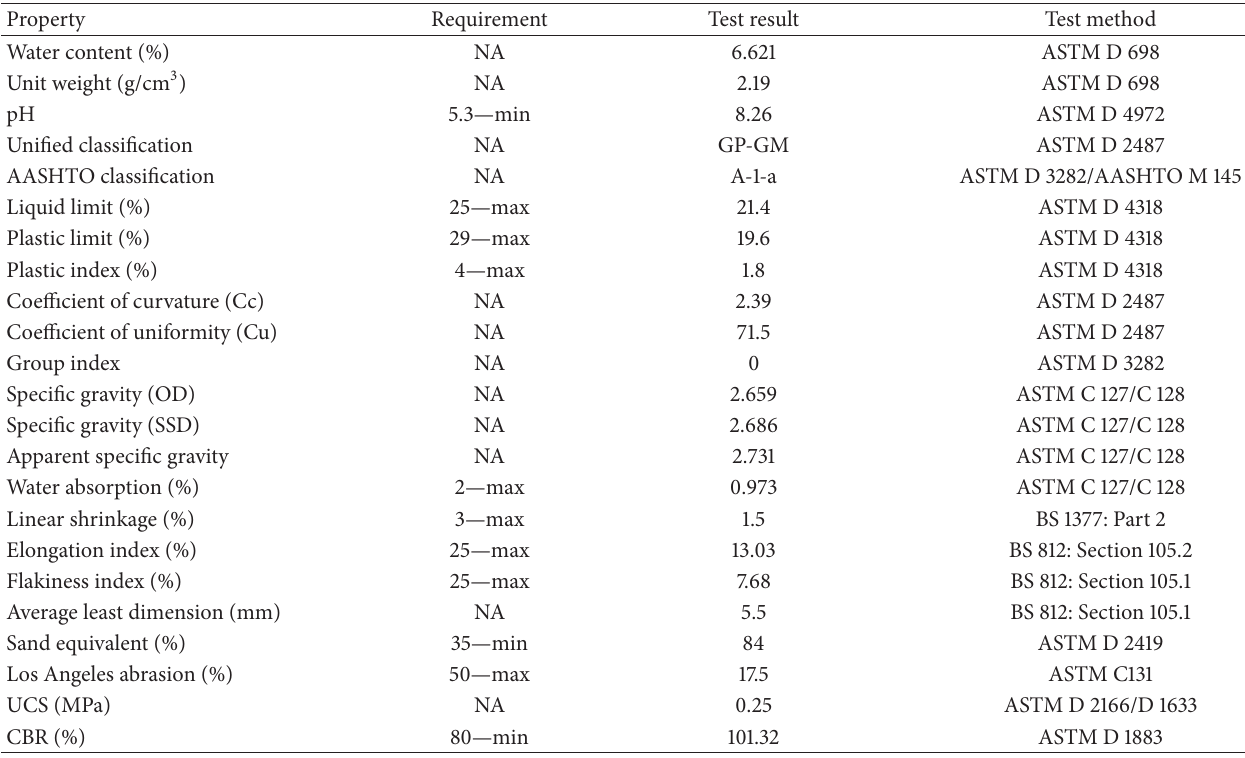
Table 1: Properties of soil-aggregates used in this study.